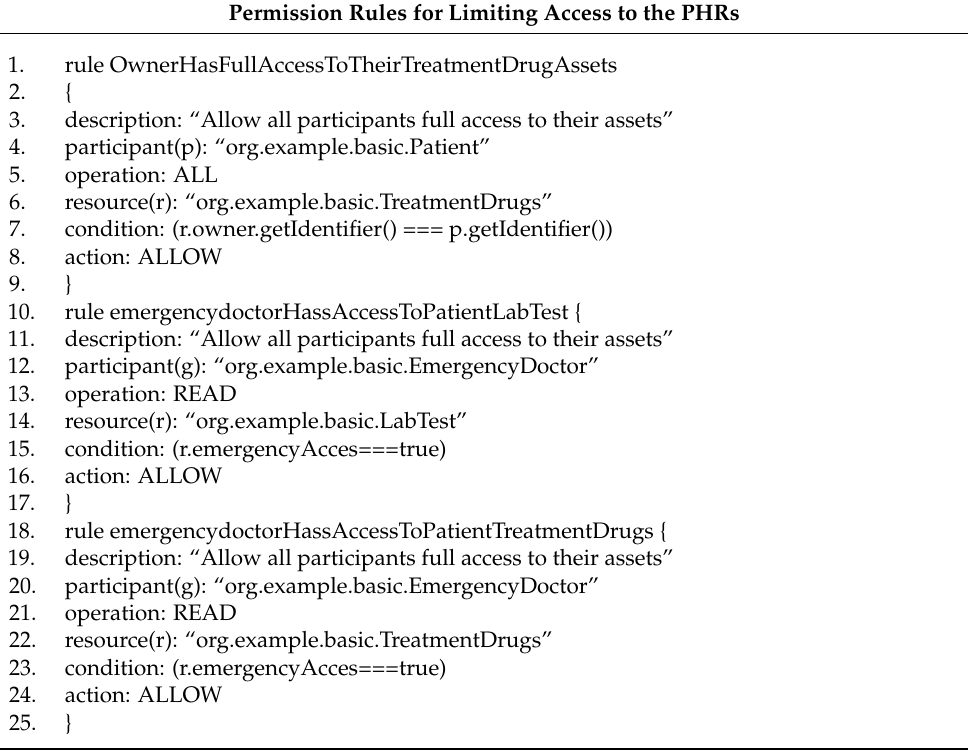
Table 3. The defined access control policies in the “permission.acl”